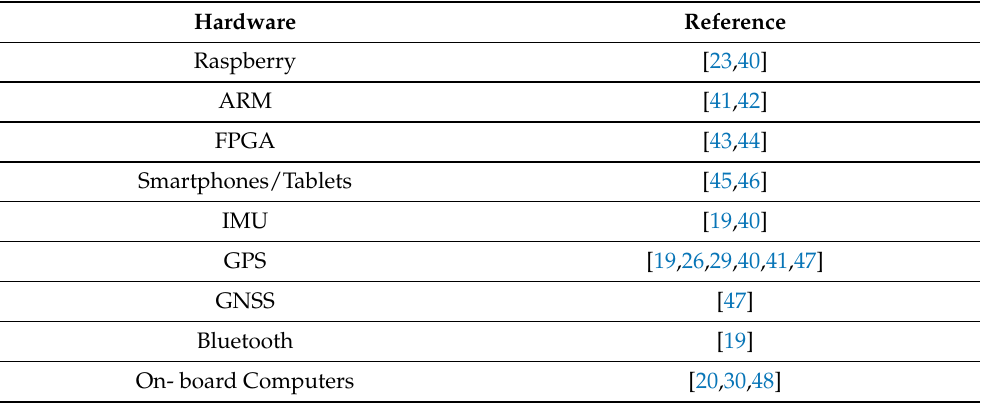
Table 2. Types of